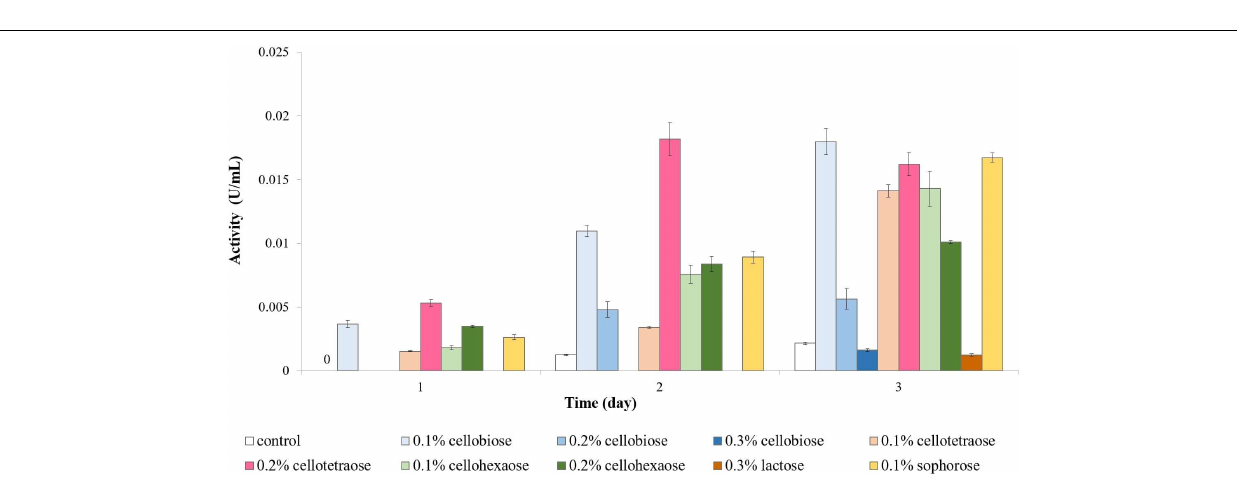
FIGURE 2 | Exoglucanase activity of sucrose-grown biomass in the presence of different inducers and using pNPC as substrate. The sample containing 0.2% lactose failed to induce any activity.